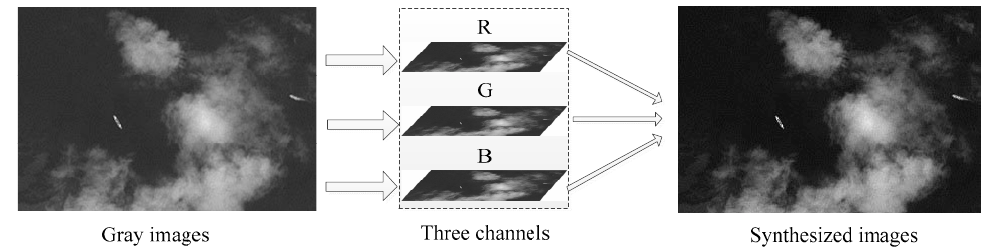
Figure 6. The transformation process.